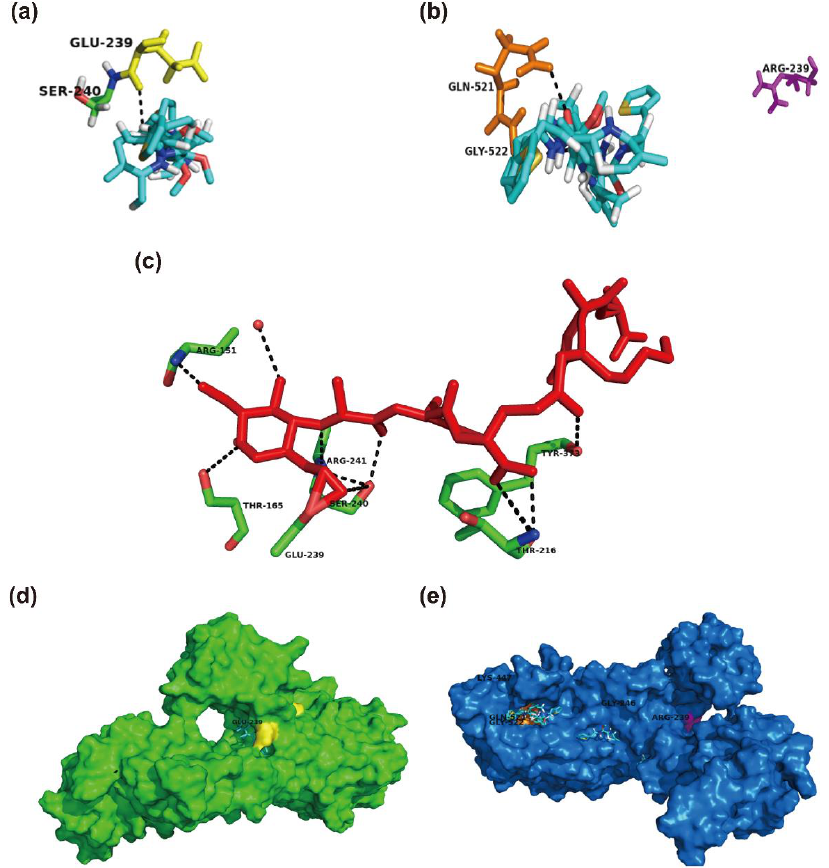
Figure 2. The protein-ligand docking of cefoxitin with the wild-type PBP2a and E239R-mutant PBP2a of MRSA. ( a ) Cefoxitin (shown in capped sticks with carbon in cyan, oxygen in red, nitrogen in blue, and sulfur in yellow) interacts with the Glu-239 (E239, yellow) of the wild-type PBP2a. The docked ligand trajectory shows that cefoxitin is located in close proximity to E239. ( b ) Cefoxitin interacts with Gln-521 (orange) and Gly-522 (orange) instead of Arg-239 (R239, pink) in the E239R-mutant PBP2a. ( c ) Peptidoglycan (red, GlcNAc-MurNAc pentapeptide) interacts with E239 and other residues of the wild-type PBP2a. ( d ) Surface representation of the wild-type PBP2a (green) showing that the ligand (shown in caped sticks) is positioned at the allosteric site (yellow). ( e ) The ligand (shown in capped sticks) is pointed away from the allosteric site (pink) in the E239R-mutant PBP2a. All of the interactions are shown as black dashed lines. Glu, glutamic acid; Ser, serine; Gln, glutamine; Gly, glycine; Arg, arginine; Thr, threonine; Tyr, tyrosine; Lys,